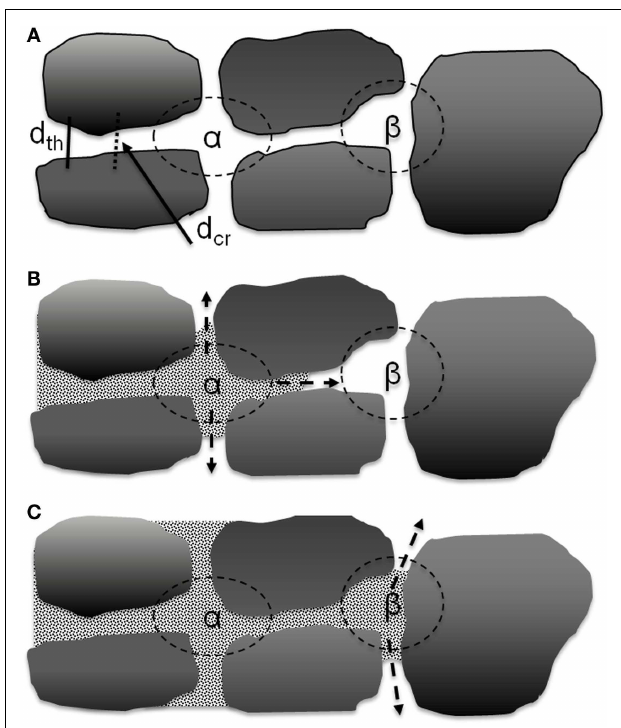
FIGURE 9 | Scheme for electrolyte transport process in the porous medium . (A) Simplified two dimensional description of a pore network with cavity α (with 4 nearby graphite particles) and cavity β (with 3 nearby particles). (B) Electrolyte transported from left to fill cavity α with 3 possible transport direction in 2D. (C) Electrolyte fills nearby cavity β with 2 possible transport directions in